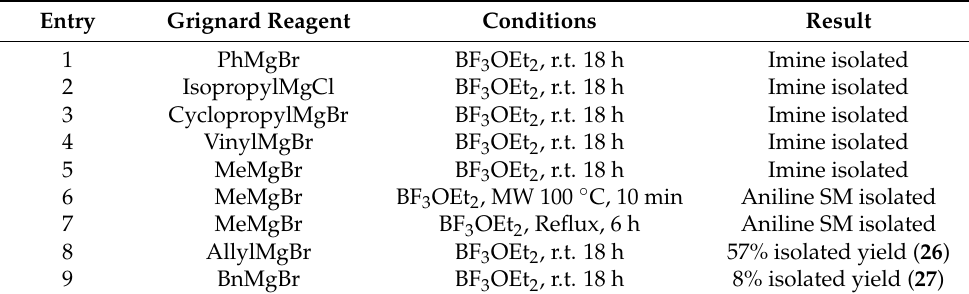
Table 6. Grignard additions into imine